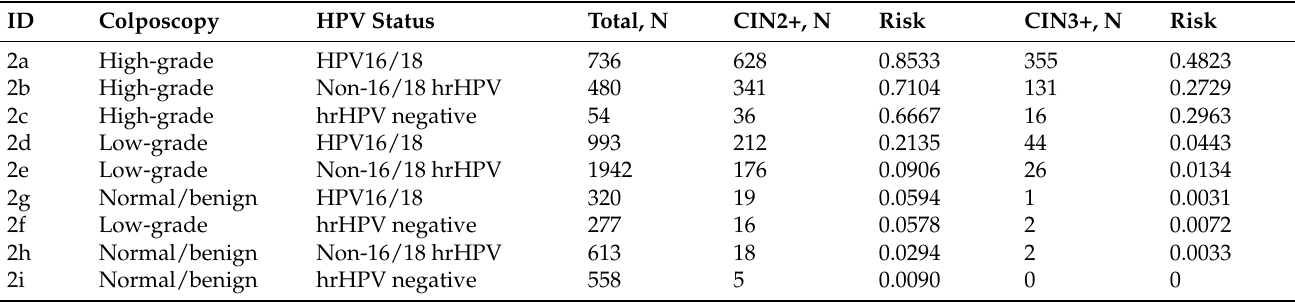
Table 4. Cervical precancers risk in strata based on colposcopy and HPV